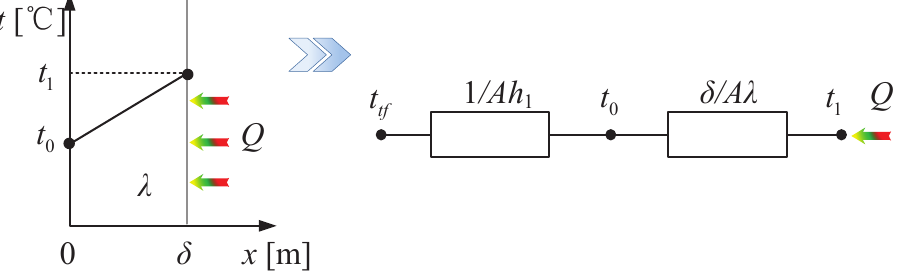
Figure 2. Equivalence of heat conduction and electric